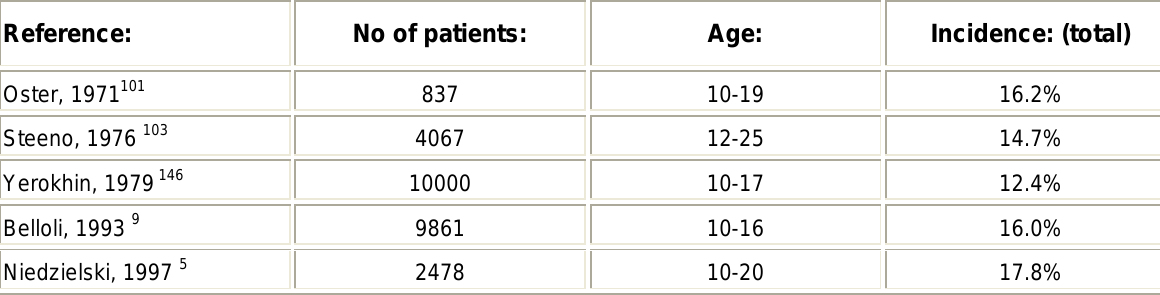
Incidence of varicocele in general population of healthy adolescents.